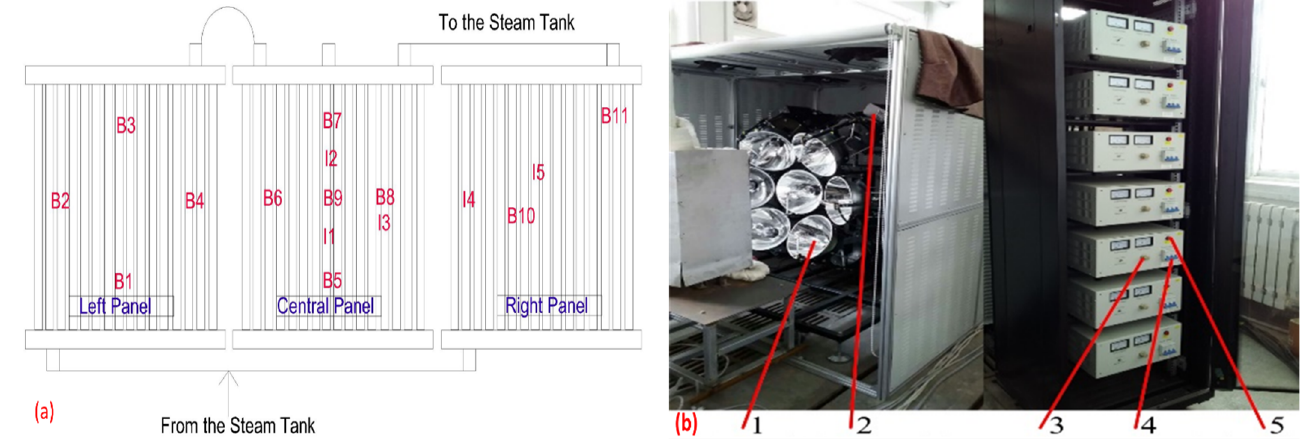
Table 2. Components of the solar simulator.